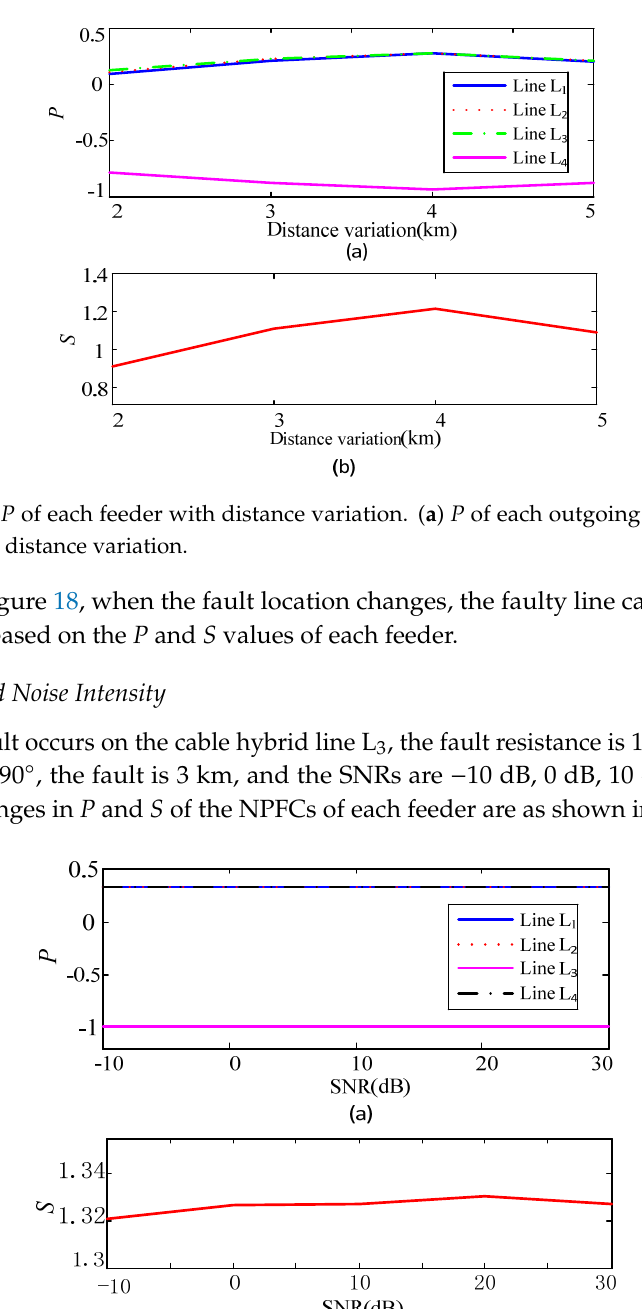
Figure 17. S and P of each feeder for different fault phase angles. ( a ) P of each feeder for different fault phase angles; ( b ) S of different fault phase angles.